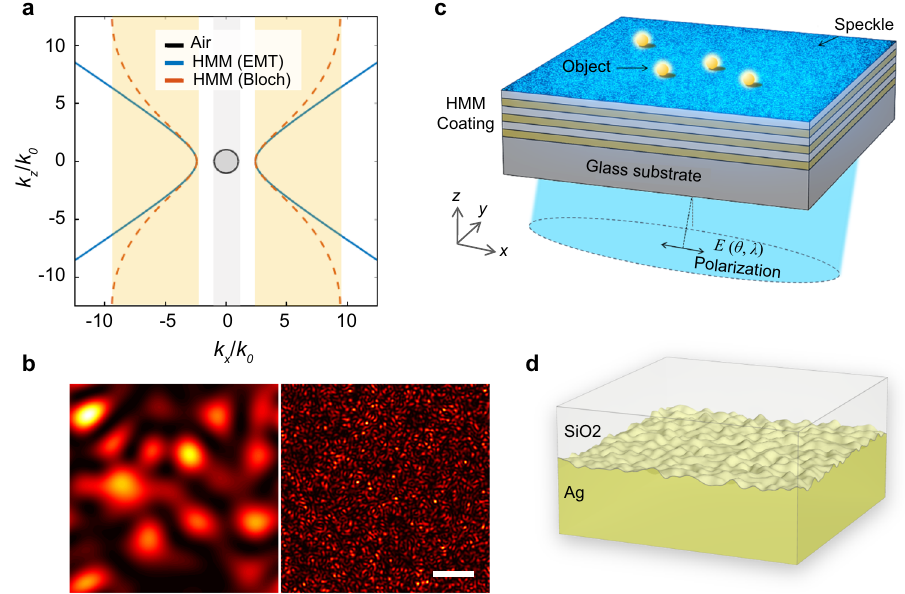
Fig. 1 Metamaterial-assisted speckle illumination. a Isofrequency curve of air, an ideal HMM by effective medium theory (EMT), and a practical HMM consists of periodical layered structures of Ag and SiO 2 (Bloch) at wavelength of 488 nm. The wave vector k x and k z are both normalized to the wave vector in air k 0 . The allowed k -bandwidth is highlighted in gray (air) and in orange (practical HMM). b Calculated exemplary speckle patterns (normalized intensity) from different material systems. Left: diffraction limited speckle (gray bandwidth in ( a )); Right: HMM assisted speckle (yellow bandwidth in ( a )). Scale bar: 400 nm. c A HMM coated substrate projects ultra- fi ne structured speckles onto objects lying on its top surface. d Schematics of the non-uniform interface between sputtered Ag and SiO 2